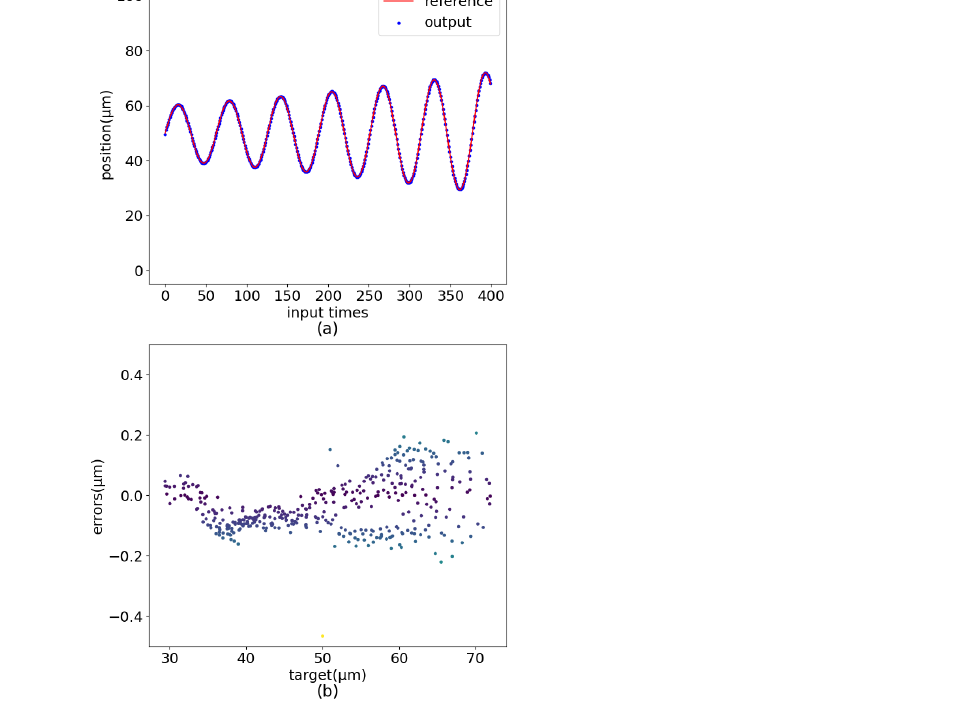
Figure 18. Amplified Sinusoidal motion control renderings. ( a ) Curve comparision. ( b ) Error